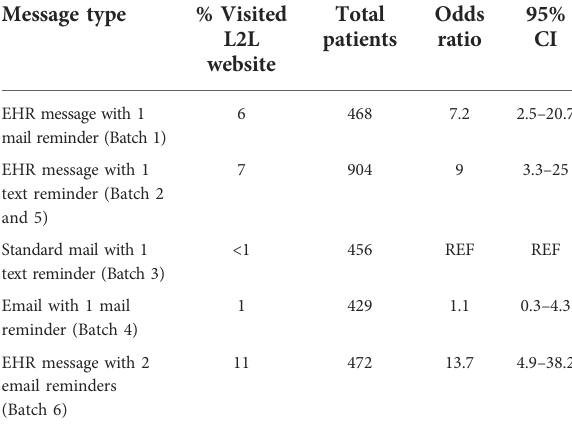
TABLE 2 Lock to Live visit and survey completion rates by outreach